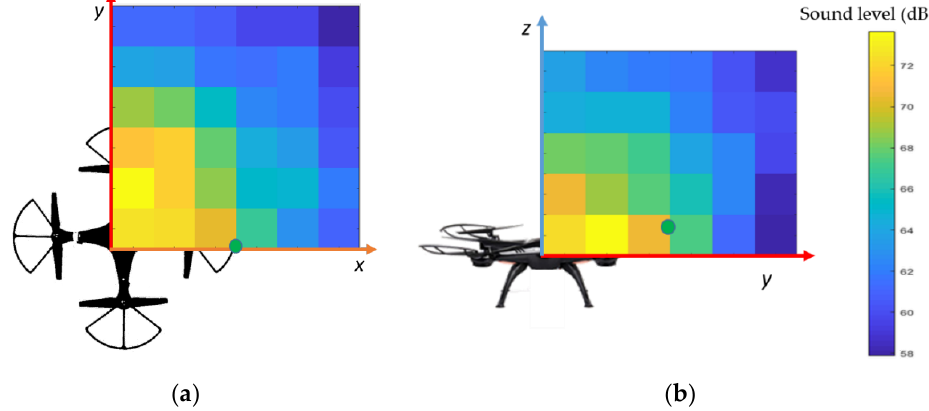
Figure A1. The horizontal ( a ) and vertical ( b ) noise distribution over the quadcopter.